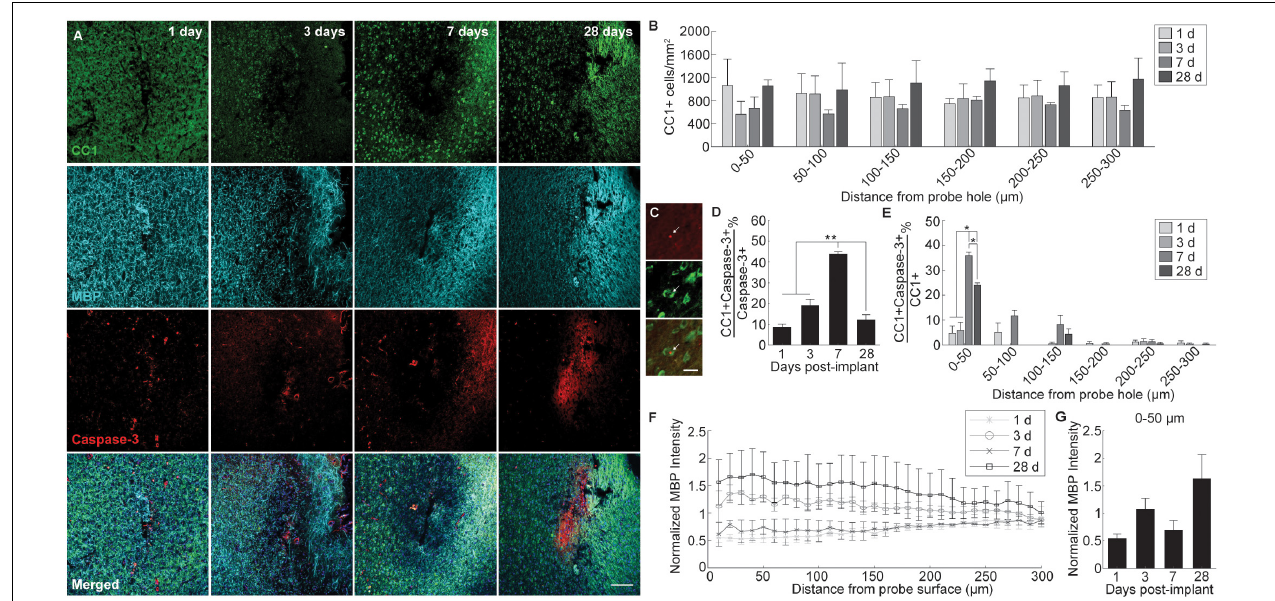
FIGURE 2 | Evaluation of oligodendrocyte cell death and myelin preservation around an implanted microelectrode array. Acute microelectrode implantation compromises oligodendrocyte viability and function, preceding abnormal myelin expression and reorganization around the electrode interface. (A) Representative immunohistochemical stain for mature oligodendrocytes (CC1), myelin (MBP), and caspase-3 at 1, 3, 7, and 28 days post-insertion. Scale bar = 100 µ m. (B) CC1 + cell counts within 50 µ m bins up to 300 µ m away from the probe hole indicating fluctuations in oligodendrocyte density around the implanted probe. Compared to neurons, oligodendrocyte densities were robust from 1 to 28 days post-insertion, fluctuating between time points but remaining relatively stable over time. (C) Magnified images of Caspase-3 + staining (top), CC1 + cells (middle), and co-labeled CC1 + Caspase-3 + cells (bottom). White arrows denote co-localized cells. Scale bar = 20 µ m. (D) Oligodendrocyte degeneration is noted as a percent of CC1 + Caspase-3 + cells over total Caspase-3 + cells within 300 µ m from the probe hole. Note : Peak oligodendrocyte degeneration preceeds peak neuronal degeneration. (E) Percent of CC1 + Capase-3 + cells over total CC1 + cells within 50 micron bins up to 300 µ m away from the probe hole. (F) Normalized MBP intensity within 10 µ m bins up to 300 µ m away from the probe hole. (G) Normalized MBP intensity averaged over the first 50 µ m from the probe hole demonstrates an increase in myelination around the site of insertion at chronic timepoints. An increase in myelination at 28 days post-insertion coincides with a decrease in oligodendrocyte degeneration, indicating a potential reparative effect. ∗ indicates p < 0.05. ∗∗ indicates p <